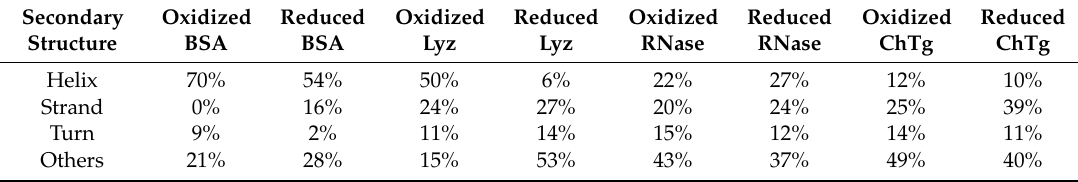
Table 2. Secondary structure analysis of the CD spectra a .